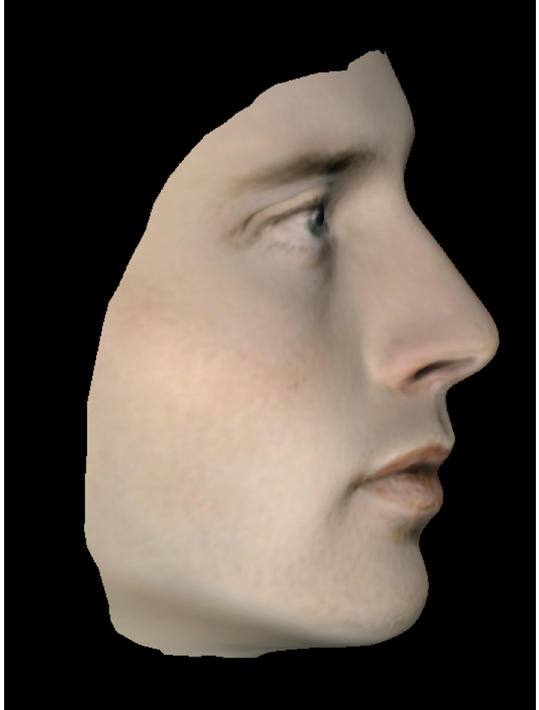
Fig. 2 : CGI Keats, Institute for Digital Archaeology/A. Karenowska, February